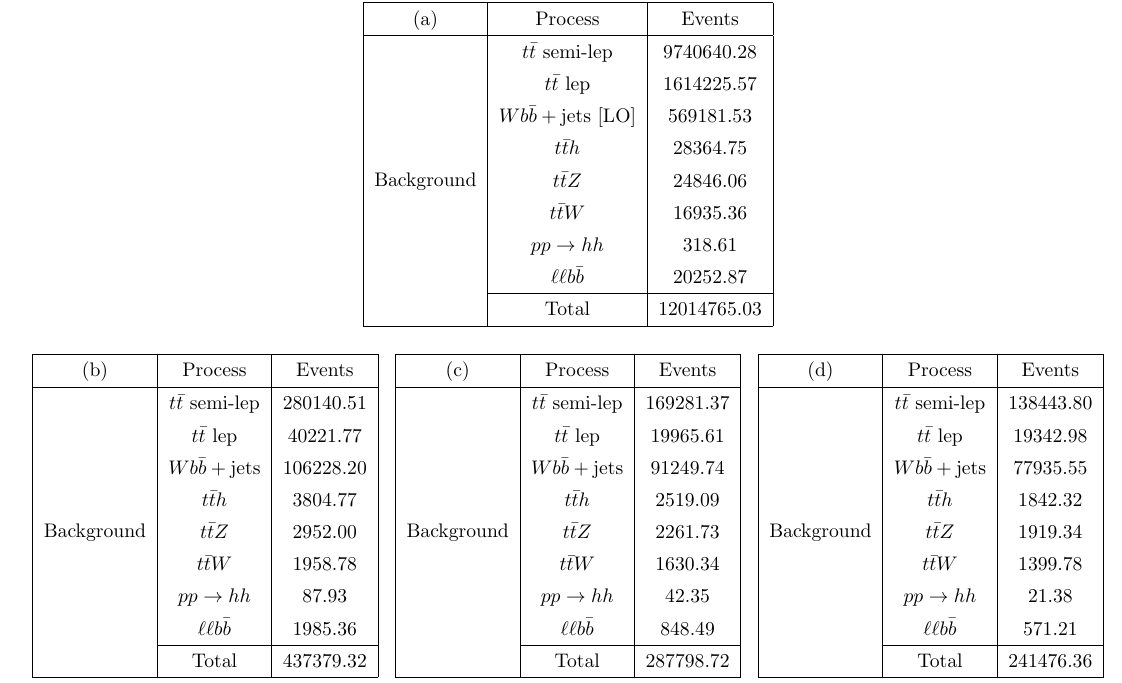
Table 12 . Respective background yields for the 1 ‘ + 2 j + 2 b + =E optimised for m H = ( a ) 400 GeV, ( b ) 600 GeV, ( c ) 800 GeV and ( d ) 1 TeV. The various orders of the signal and backgrounds are same as in table 11.